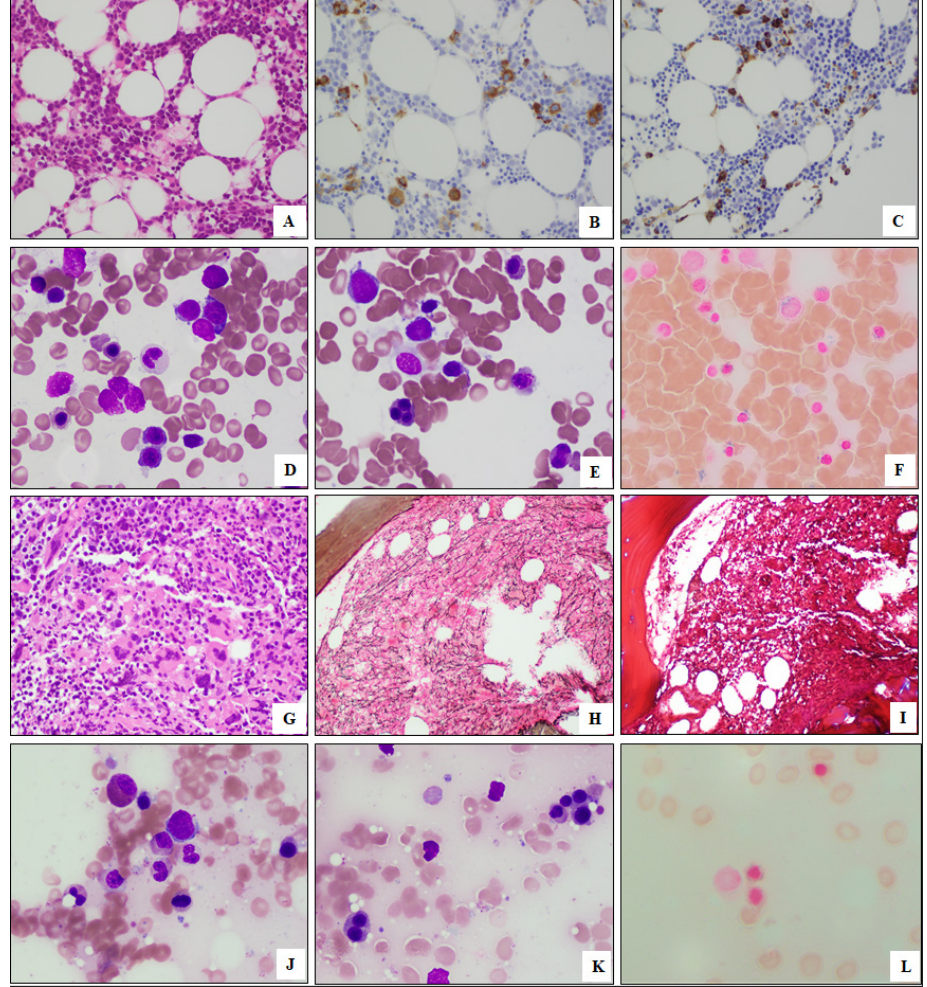
Figure 1. Morphologic features of representative cases of myeloid neoplasms with SF3B1 and PHF6 mutations. ( A – F ) A case of myelodysplastic syndrome with multilineage dysplasia, increased blasts, and fibrosis. The bone marrow is hypercellular for age ( A , H & E ) with dysmegakaryopoiesis ( B , CD61) and increased blasts ( C , CD34). The aspirate smear shows dysgranuopoiesis ( D , Wright-Giemsa), dyserythropoiesis ( E , Wright-Giemsa), and increased ring sideroblasts ( F , Prussian Blue) ( A – C , 200 × ; D – F , 500 × ). ( G – L ) A case of primary myelofibrosis. The bone marrow is hypercellular ( G , H & E ), with reticulin fibrosis ( H ), without collagen fibrosis ( I ). The aspirate smear shows dysgranulopoiesis ( J , Wright-Giemsa), dyserythropoiesis ( K , Wright-Giemsa), and increased ring sideroblasts ( L , Prus- sian Blue) ( G – I , 200 × ; J – L , 500 ×